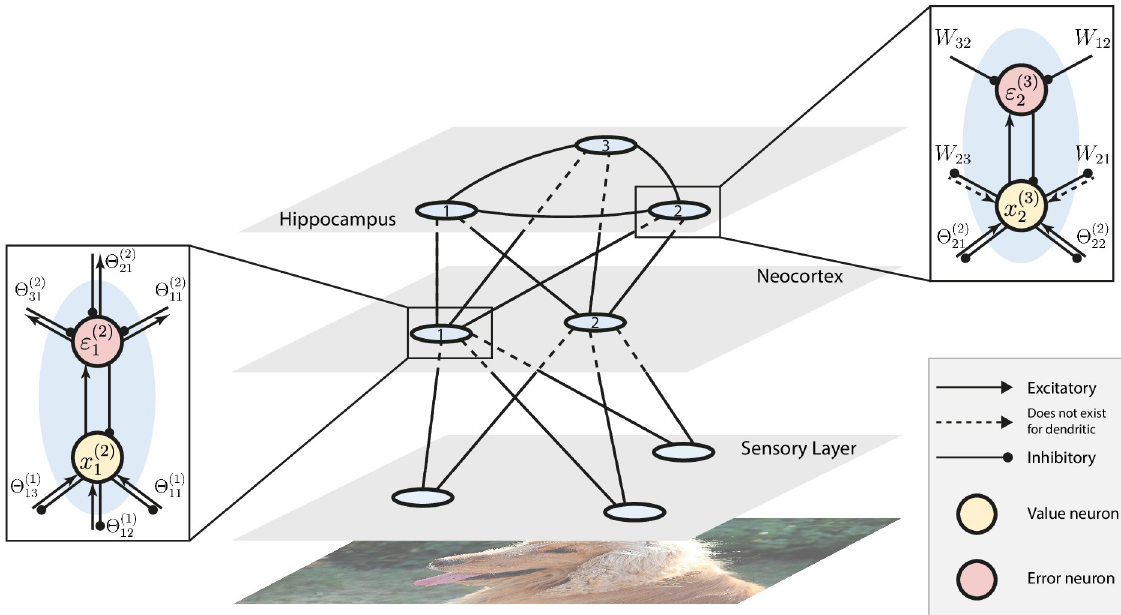
Fig 2. Multilayer hybrid PCN. We use the single-layer implicit/dendritic covPCN to model the hippocampus, and a hierarchical PCN from [12] to model the sensory cortex and neocortex. Neurons and synapses in the hierarchical layers follow the dynamic rules in [12]. For clarity of demonstration, only one layer of our neocortex model is shown. Expanded boxes show the detailed computations within individual neurons and related synapses specified in Eqs 20 and 22, where x ð l Þ denotes the a -th neuron in the l th layer, and Θ ab and W ab denote the individual a weights from the a th to the b th neurons. Dog image in this figure is obtained from Wikimedia Commons under a CC BY 4.0